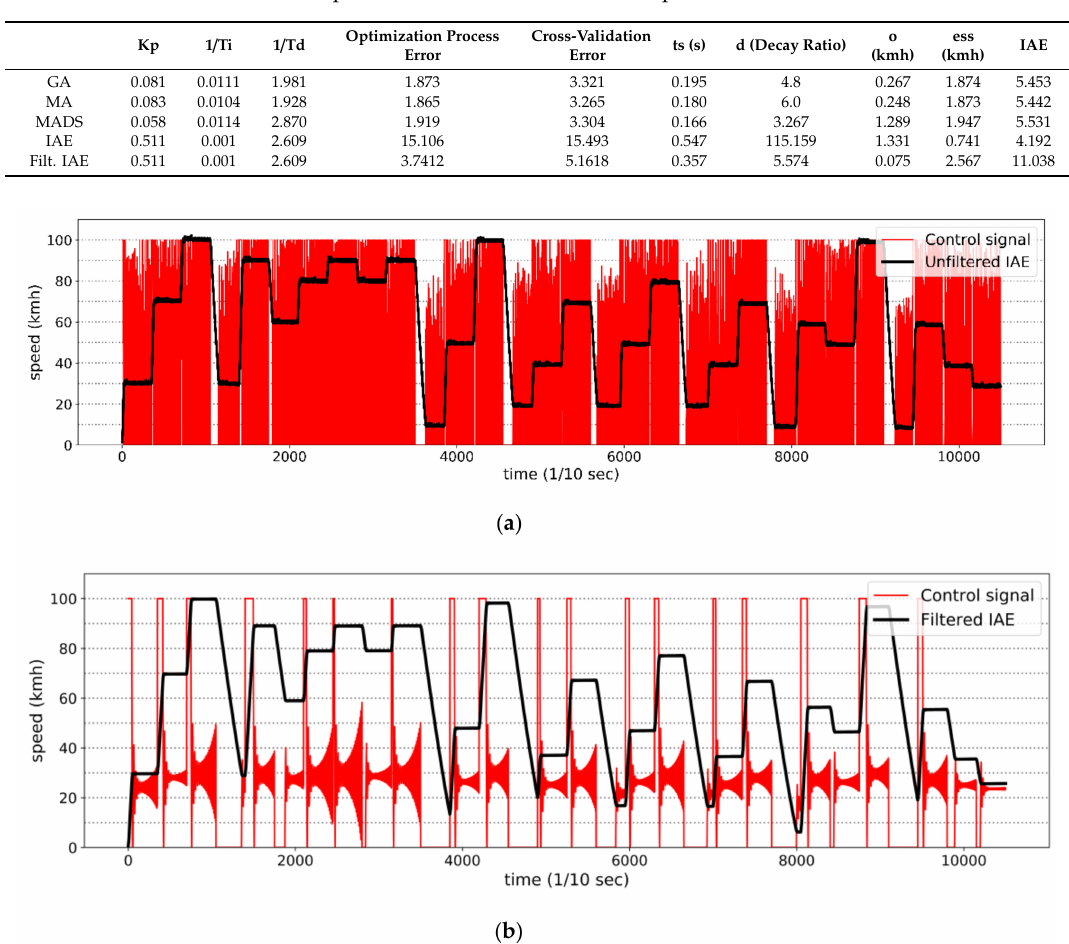
Table 1. Comparison of errors of the selected optimization methods.